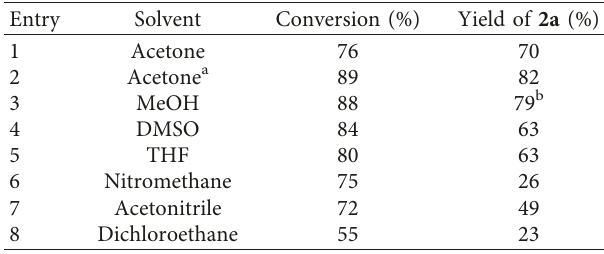
Table 2: Effect of NBS amount on bromohydroxylation of 1a . Table 3: Solvent effect on the bromohydroxylation of 1a .